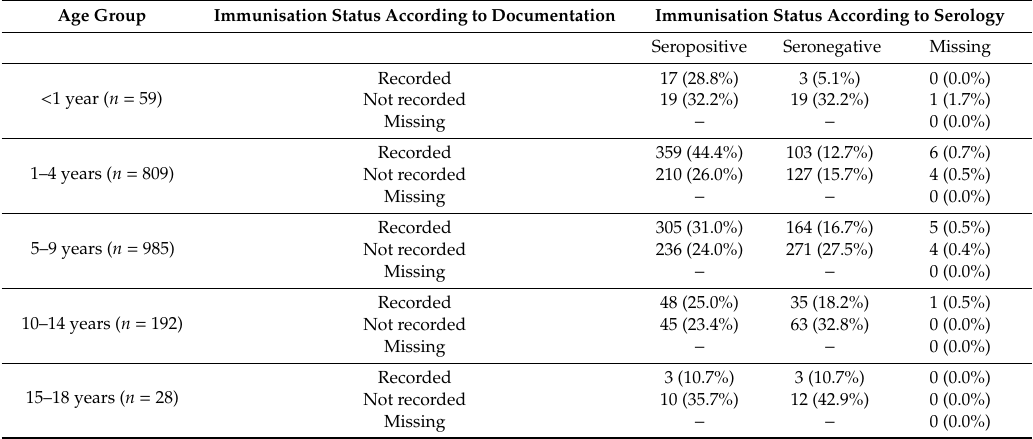
Table A7. Comparison between immunisation status of IAC reported in the documentation and serology for hepatitis B, by age group.